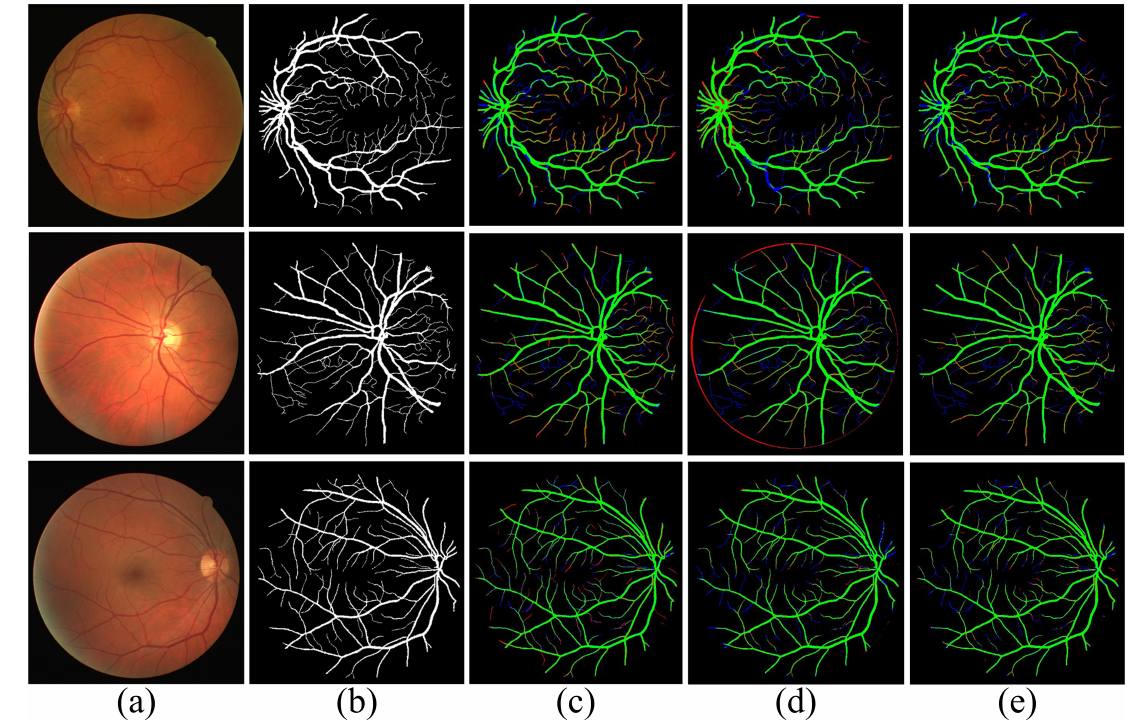
Figure 3. Analysis of segmented output. The segmentation maps’ black and green colours represent accurately predicted pixels, whereas the blue and red colours represent false negatives and false positives, respectively: ( a ) noisy test images 3, 4 and 19 of the DRIVE dataset; ( b ) corresponding ground truth images from the 1st manual; ( c ) the output of SegNet [48]; ( d ) the output of U-Net [49]; ( e ) the output of the proposed G-Net light architecture.